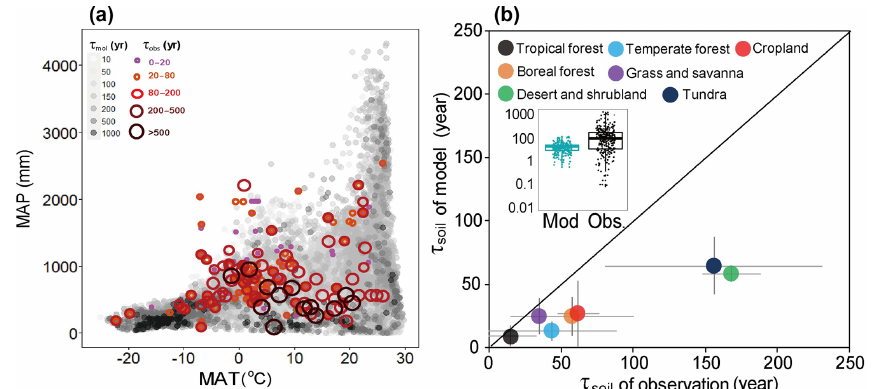
Figure 2. Global spatial variation of SOC transit time ( τ soil ) with climate and the difference of τ soil estimation between observations and models. (a) Spatial variation of τ soil with mean annual temperature (MAT) and mean annual precipitation (MAP). (b) Comparisons of modeled against observed τ soil . Details for the classification of biomes are provided in the method section.